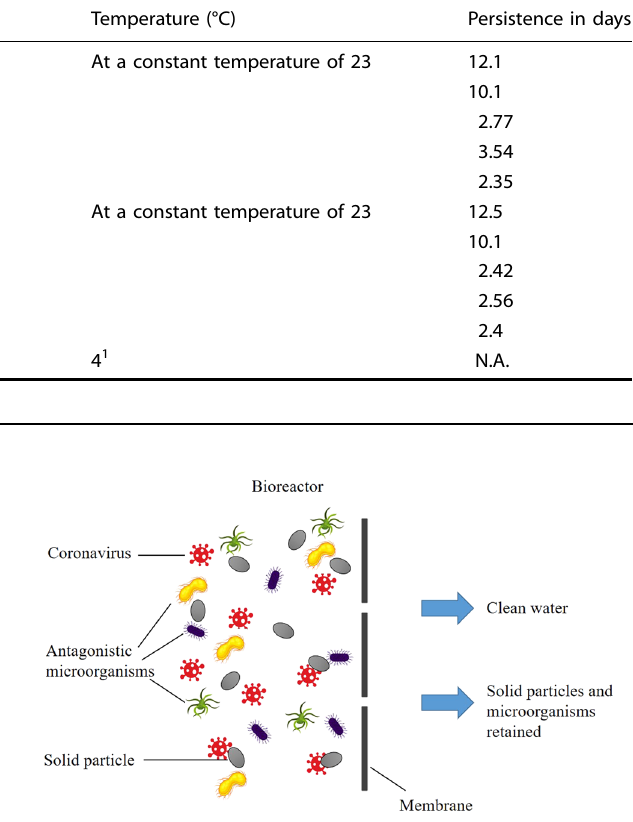
Fig. 4 Membrane bioreactor containing antagonistic microorgan- isms along with coronaviruses.